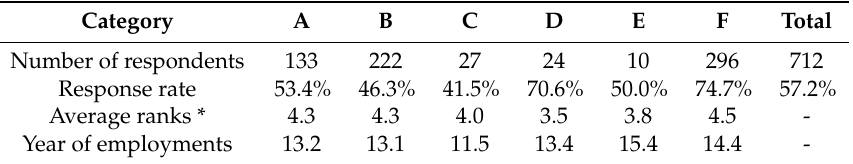
Table 6. Basic information about survey